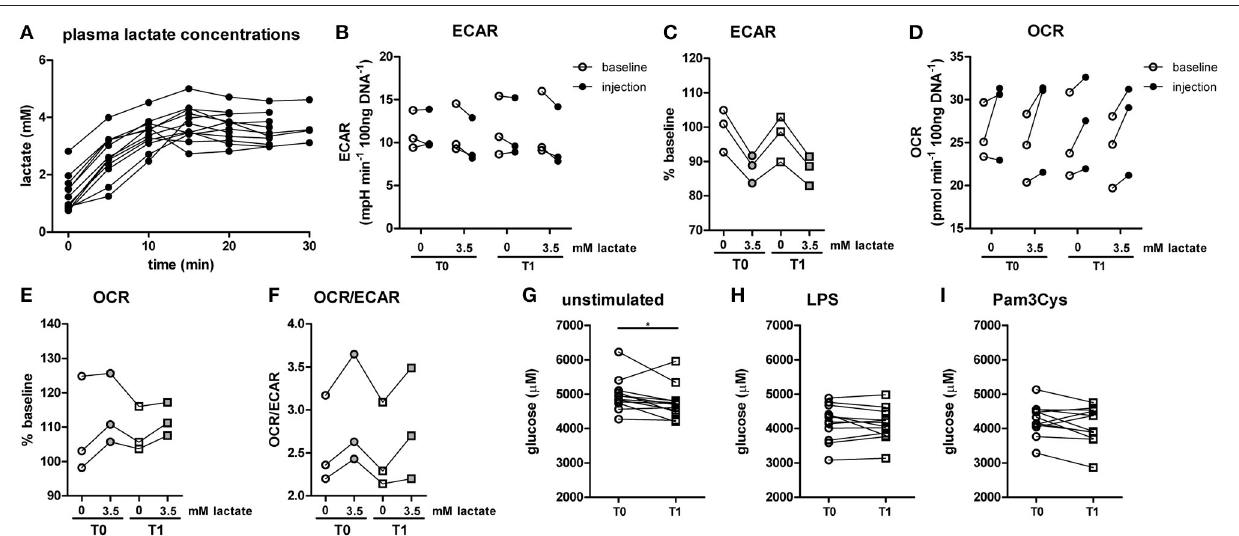
FIGURE 5 | A short-term lactate infusion only has minor effects on human immune cell metabolism. (A) Plasma lactate concentrations measured during lactate infusion. (B–E) Change of ECAR (B,C) and OCR (D,E) in human CD14 + monocytes after exposure to lactate, presented as raw data and % baseline (before lactate injection). (F) OCR/ECAR after lactate injection. (G–I) Glucose concentration assessed in the medium of cultured PBMCs from patients with diabetes. PBMCs were isolated and stimulated either before (T0) or after (T1) lactate infusion. PBMCs were stimulated with LPS or Pam3Cys for 24h. Each dot represents one patient. (A,G–I) n = 12, (B–F) n = 3. * p < 0.05, Friedman test with post-hoc Dunn’s